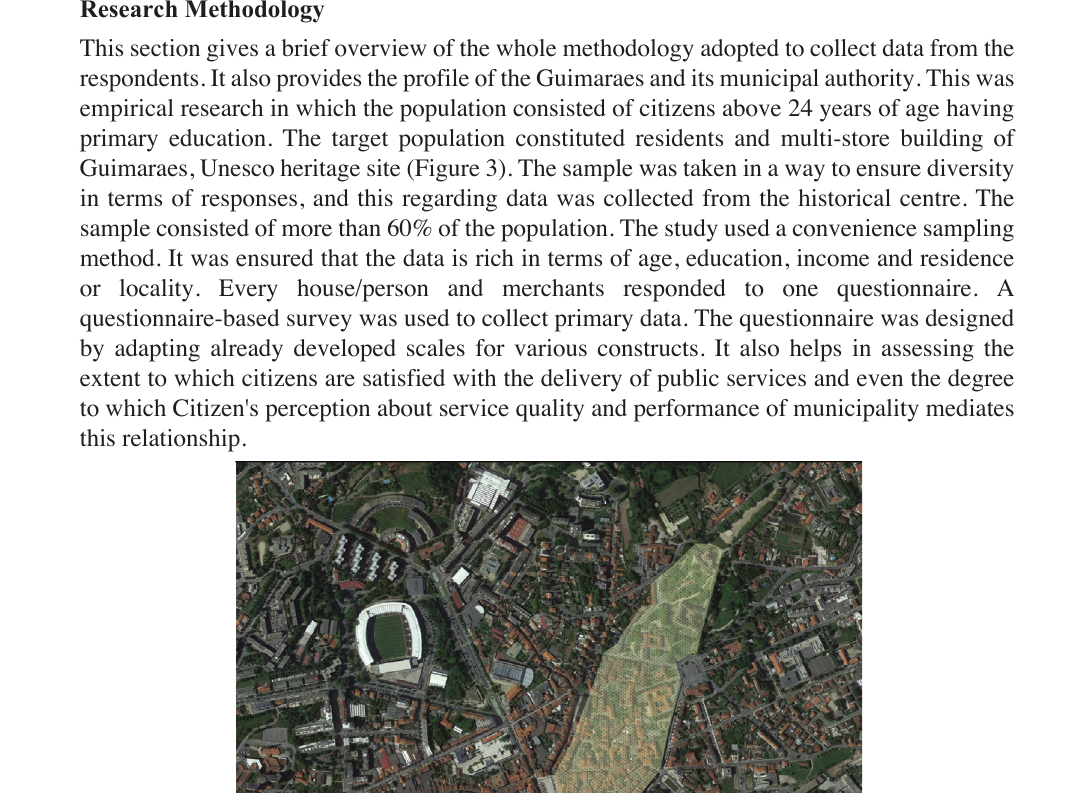
Figure 3: Guimaraes UNESCO Heritage Site